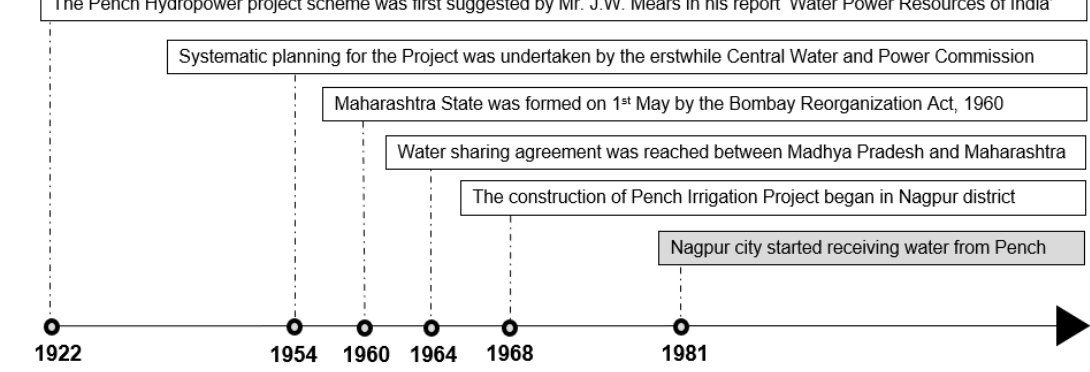
Figure 3. Historical timeline of the Pench Project. Information source: Reference [109].